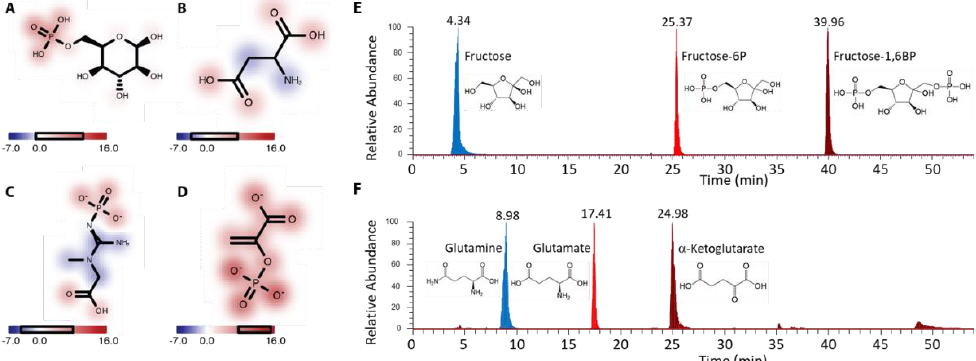
Figure 4. The effects of different functional groups on retention time: In each subfigure, atoms are colored by their effect Є on the MM retention time, with atoms colored red increasing the retention time and atoms colored blue decreasing the retention time. The color bar indicates the range of Є in minutes. Phosphate groups are readily identified in ( A , C , D ) as strongly increasing retention time. Carboxylic acids contribute to a lesser degree as seen in ( B – D ) while amine and amide groups are observed to strongly contribute to decreasing elution time in ( B , C ). Empirically, ( E ) phosphate increases retention of fructose to F6P and FBP, whereas ( F ) replacing a ketone or carboxylic acid with an amine or amide, respectively, reduces retention from aKG to Glu to